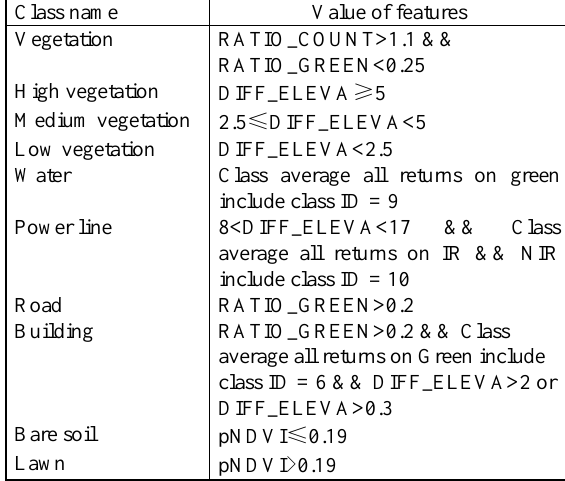
Table 1. Class hierarchy and rule sets based on OBIA